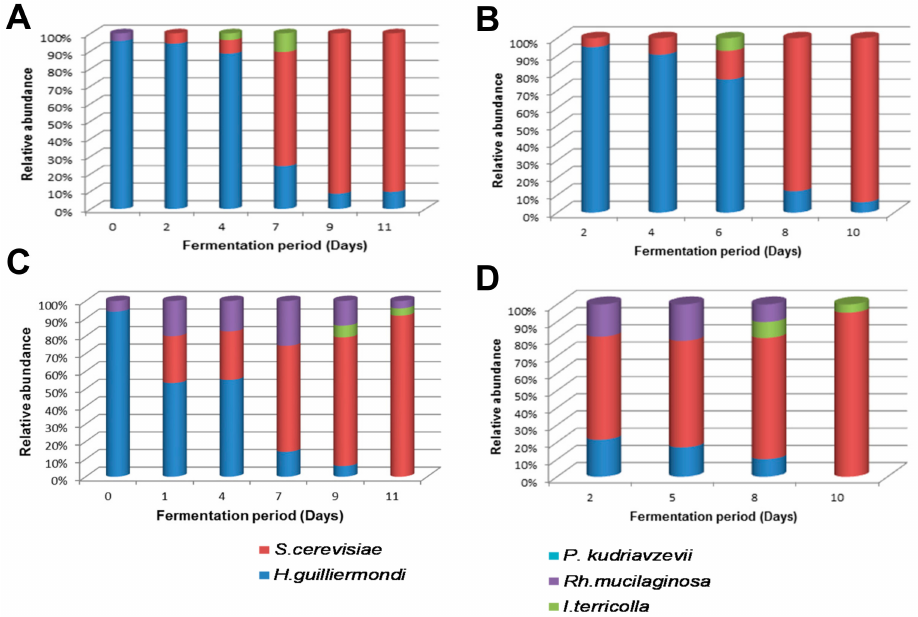
Figure 4. Yeast species identified in marula wines from Lab ( A ), Mentz ( B ), Moshira-A ( C ) and Moshira-B ( D